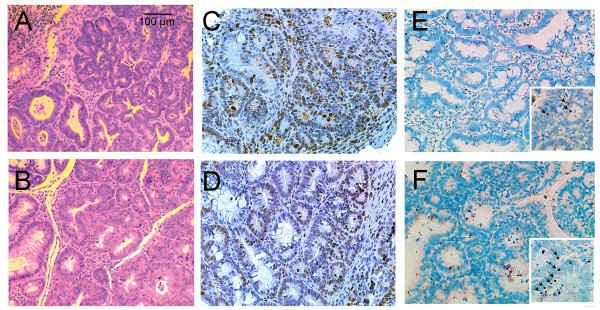
Ginseng reduces proliferation and increases apoptosis in AOM/DSS-induced tumors from mice fed a Western diet. A. H&E stained tumor from mouse on Western diet alone; (20×); B. H&E stained tumor from mouse on Western diet supplemented with 250 ppm Wisconsin ginseng extract (20×); C. Ki67 in tumor from WD fed mouse, (20 x); D. Ki67 in tumor from mouse on WD plus ginseng (20×). Note the increased brown staining (Ki67 positive nuclei) in C compared to D; E. TUNEL staining in tumor from WD fed mouse (20×); F. TUNEL staining in tumor from mouse on WD plus ginseng (20×). Inset 40× magnification. Note the increased apoptotic bodies indicated by black arrows in F compared to E.